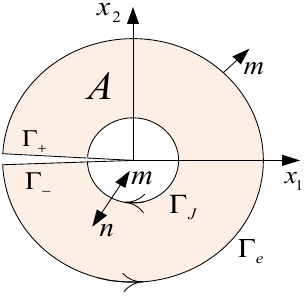
Figure 5. J integral contour around the crack tip.